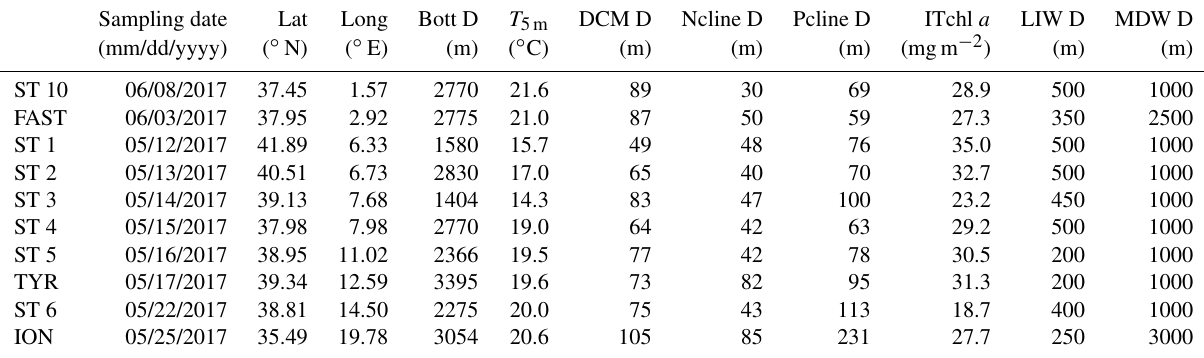
Table 1. Characteristics of the stations. Lat: latitude; Long: longitude; Bott D: bottom depth; T 5m : temperature at 5m depth; Ncline depth: nitracline depth, calculated as the layer where NO 3 reaches 50nM; Pcline depth: phosphacline depth, estimated as the layer where DIP reaches 50nM; ITchl a : 0–250m integrated total chlorophyll a ; LIW D: depth of the LIW layer sampled; MDW D: depth of the MDW layer